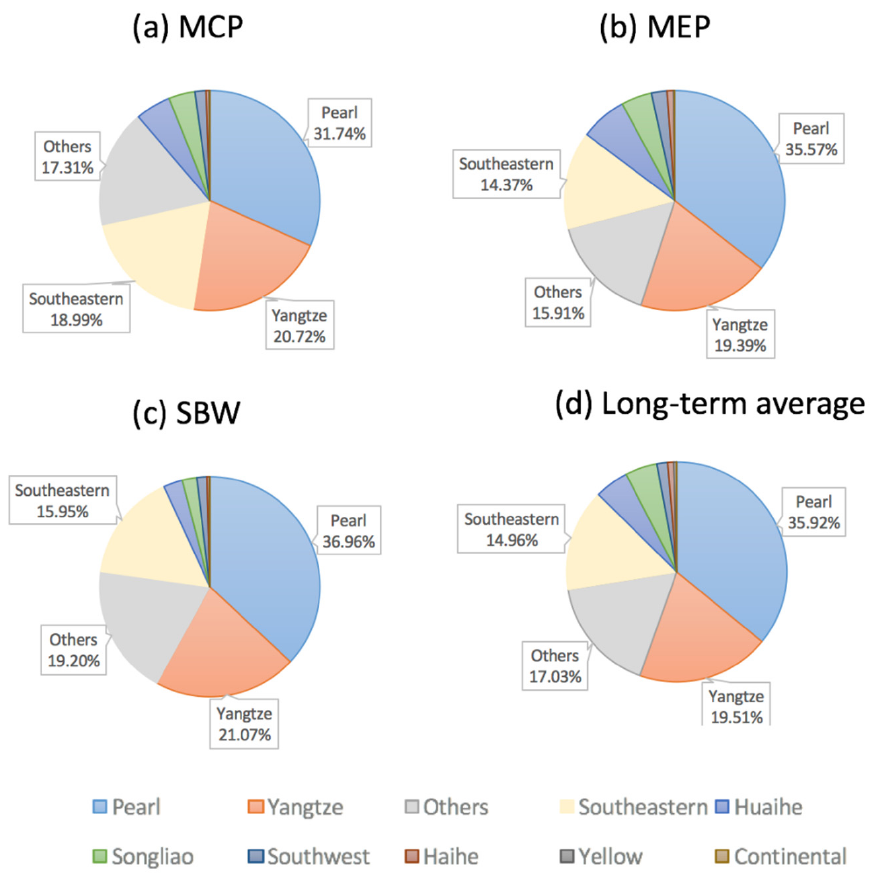
Figure 6. Proportion of tropical cyclone-induced precipitation amount in each river basin of China. ( a – c ) show results for moderate central Pacific (MCP), ( b ) moderate eastern Pacific (MEP), and ( c ) strong basin-wide (SBW) El Niño events, respectively, and ( d ) shows the long-term average. Figure 7 compares TC-induced composite PRCPTOT anomalies with the long-term values observed at each station throughout China. The four significance levels were determined based on Welch’s t -test. Total seasonal precipitation was concentrated in the Yangtze, Pearl, Hong Kong, and Southeastern river basins during MCP development. Then, rainfall moved to the coastal areas of Huaihe and Southeast. During MEP El Niño events, rainfall continued to fall in the Southwest, Pearl, and Songliao river basins. In addition, during SBW events when rain moved to the Yangtze and Hong Kong river basins, more rain was concentrated in the Huaihe, Haihe, and Songliao regions. During the emergence of MEP and SBW events and the decay of MEP events, the Songliao River Basin experienced more TC-induced rainfall than usual. TC-induced rainfall was slightly reduced during SBW events, and TC-induced rainfall increased in the Southeast during MCP decay. The maximum rainfall over China noticeably reduced. However, there was slightly more rain in Hong Kong, and Songliao experienced slightly more rain under MEP decay. The Yangtze and Pearl regions received relatively more rain in almost all cases. Therefore, the results suggest that TC-induced rainfall varied with TC